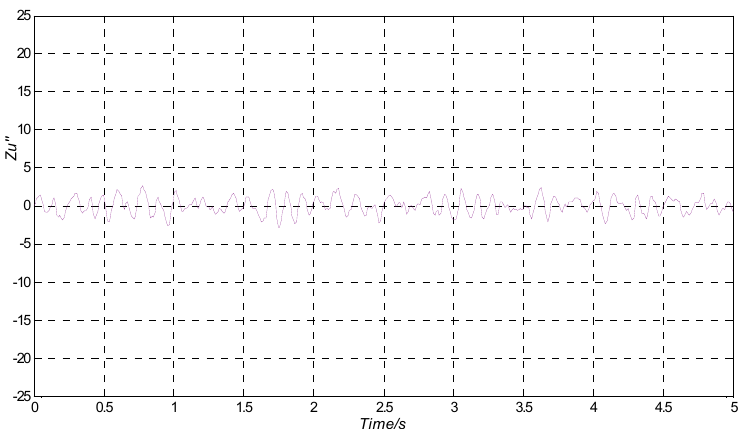
Figure 14. Optimum vertical acceleration of Reference [9] based on the OSMC controller.